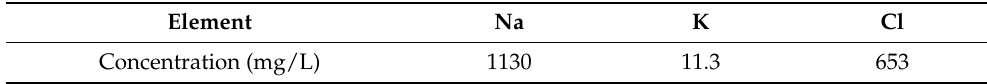
Table 2. Chemical composition measured by ICP of the industrial effluent. Element Na K Cl Concentration (mg/L)